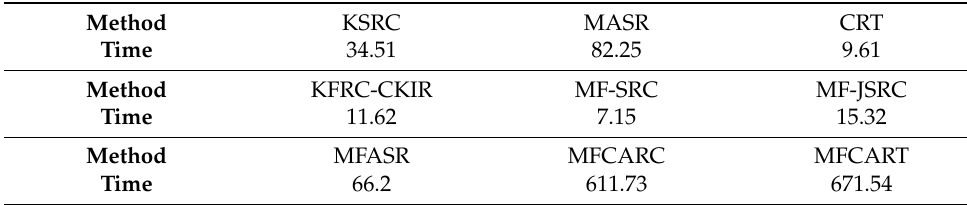
Table 12. Execution time (in seconds) for the classification of the Indian Pines data